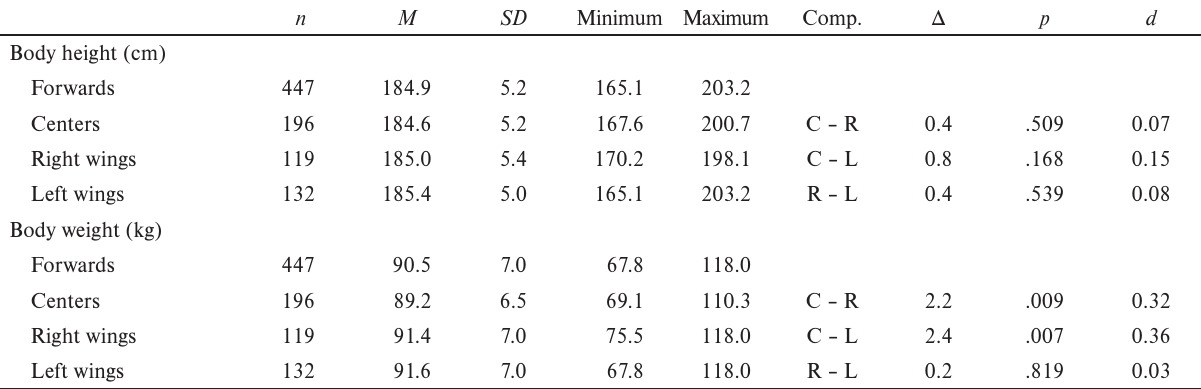
Body height and body weight and statistical comparison of differences and effect size of current ice hockey forwards of NHL